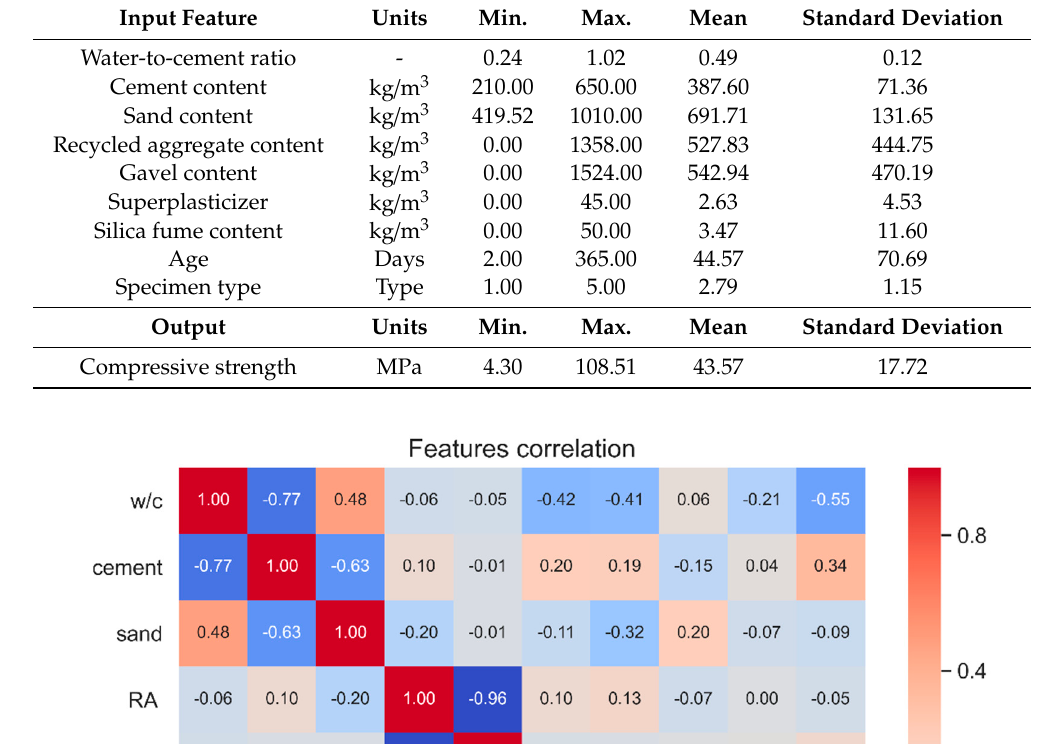
Table 3. Statistical characteristics of the dataset.